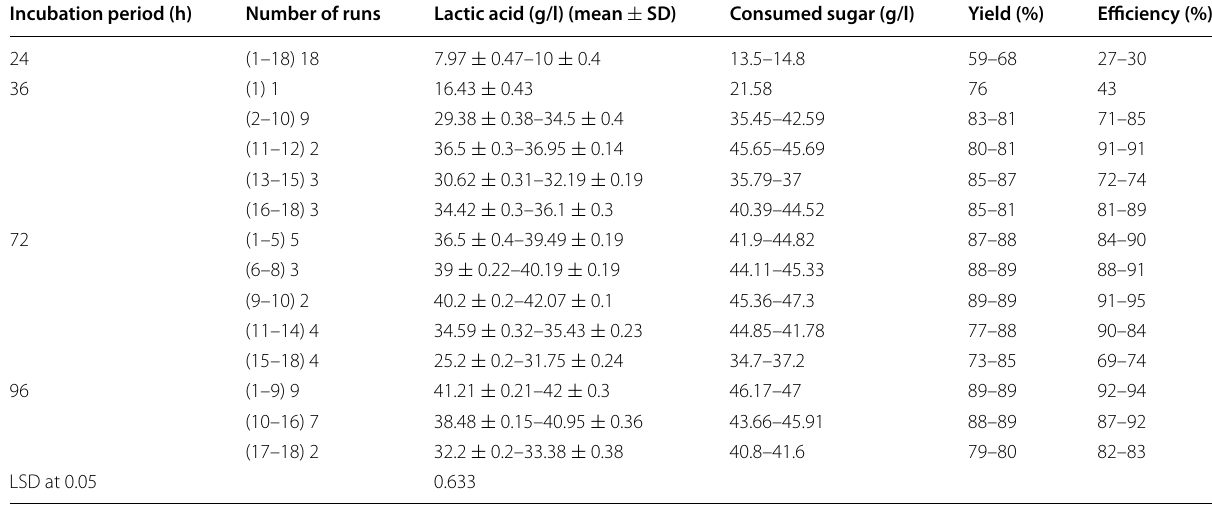
Substrate: salted cheese whey and whey permeate mixture (1:1) with CaCO 3 (0.5%), inoculum size